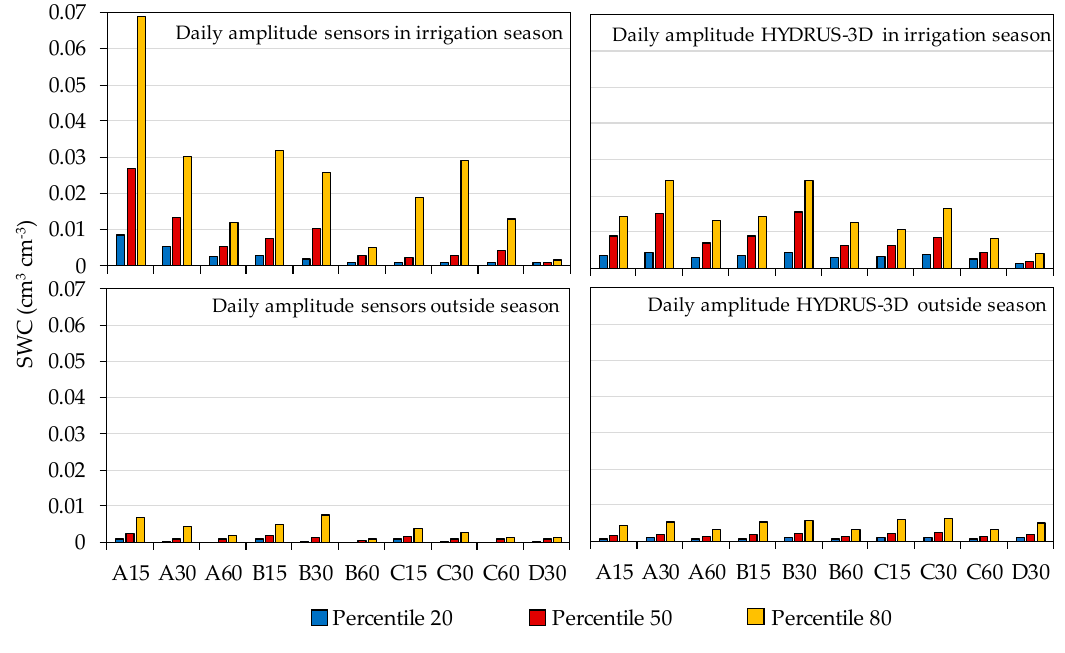
Figure 8. Daily amplitude of the measured and simulated soil water contents at different position and depth.